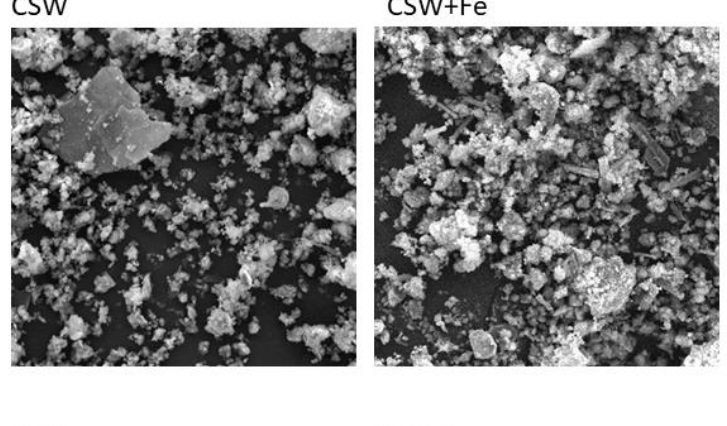
Figure 2. Original ( left ) CSW and TSW and Fe-modified ( right ) CSW Fe and TSW Fe . The SEM micro-observation of initial and Fe-modified CSW and TSW (Figure 3) showed the growth of new phase in both Fe-modified sorbents, which was related to the higher S BET of CSW Fe /TSW Fe (Table 1), probably caused by the new amorphous Fe-phase arising on the CSW/TSW surface [9]. Although the S BET increased in both Fe-modified sorbents, which corresponded to the amorphous character of new Fe-phases, its orders of magnitude higher values for CSW/CSW Fe indicated a much finer-grained material with smaller particles, where better sorption properties were expected [7,21]. Similarly, the porosity of CSW and TSW differed markedly. While the total pore volume of CSW/CSW Fe ranged in tenths of a cm 3 .g −1 , the total porosity of TSW/TSW Fe was two orders of magni- tude lower (Table 1). Using the t-plot method, no micropores were detected in CSW/CSW Fe and TSW/TSW Fe . According to the parameters discussed above, TSW proved to be a coarser-grained material with a lower S BET and worse sorption assumptions compared to CSW, in both original and Fe-modified forms.